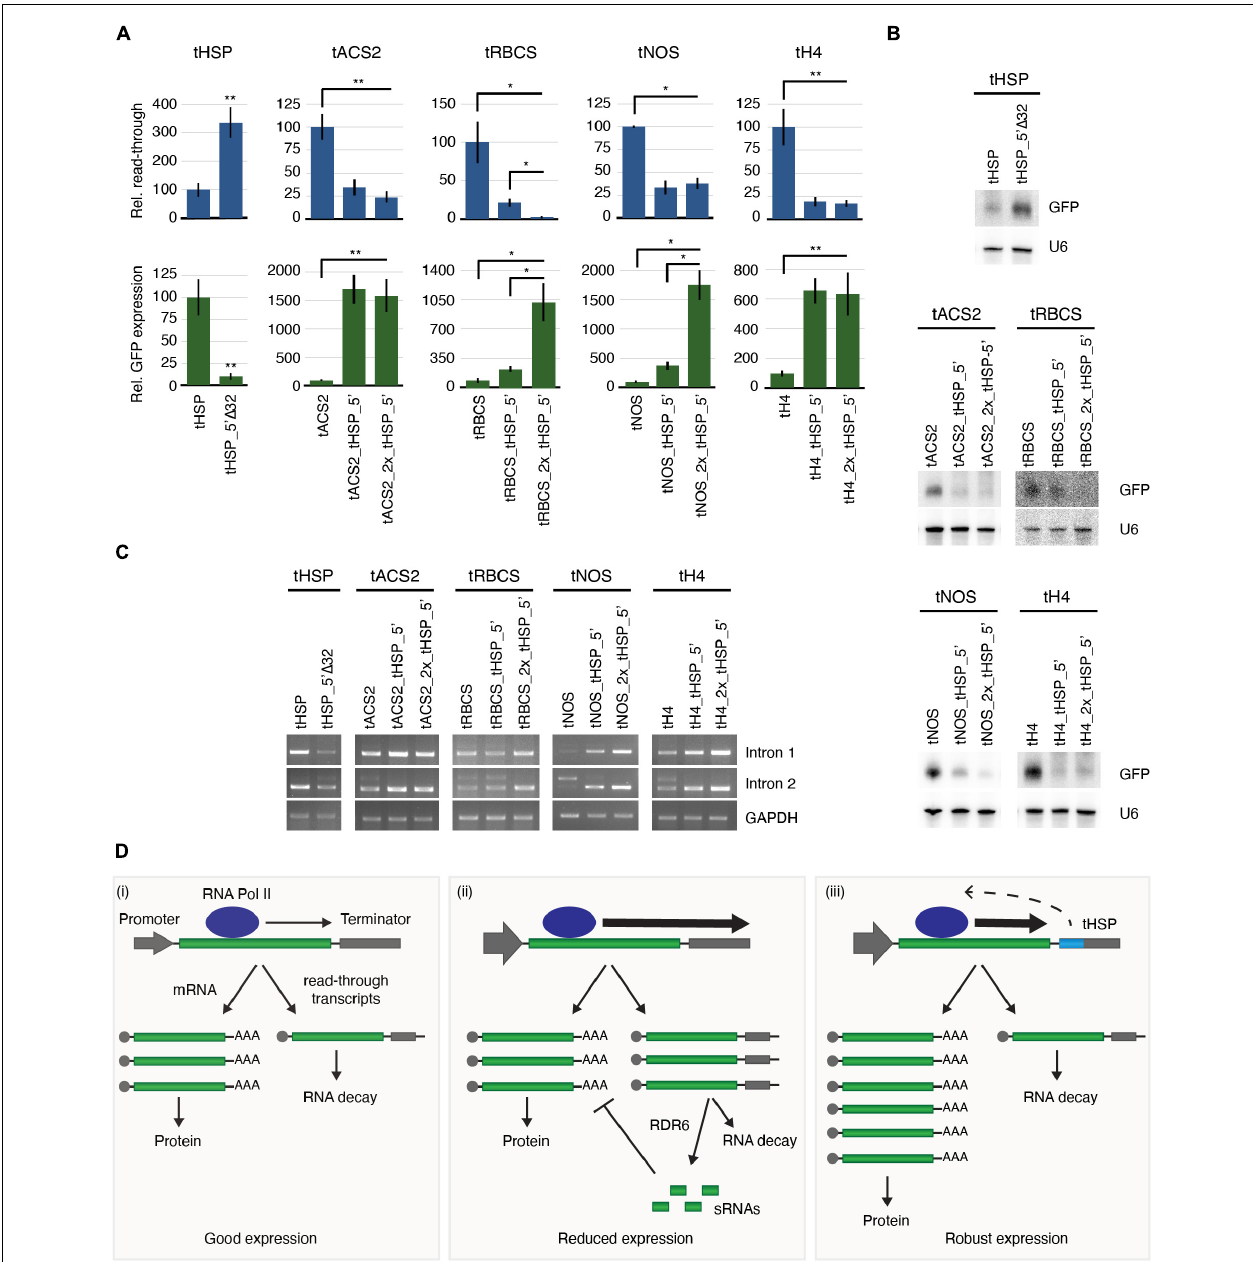
FIGURE 7 | The role of the tHSP 5 (cid:48) fragment on transcription termination, protection against sRNA production and splicing. (A) RT-qPCR analysis to detect read-through and GiFiP expression levels. All values are normalized to GAPDH ( GLYCERALDEHYDE 3-PHOSPHATE DEHYDROGENASE ) and are relative to the wild-type regulatory sequence. Read-through refers to the detection of a region of the T-DNA downstream of the terminator sequence. For the RT-qPCR analyses, three (tRBCS), four (tNOS), or six (tHSP, tACS2 and tH4) biological replicates were used. Each replicate is an infiltration spot originating from an independent plant. Standard error bars were calculated for the biological replicates. Statistically significant differences observed between the original and modified terminators, or between constructs carrying one versus two fragments of the tHSP (Mann-Whitney U test) are indicated by “*” ( p ≤ 0.05) or “**” ( p ≤ 0.01). (B) Northern blot to detect sRNAs derived from the GiFiP reporter. U6 was used as the RNA loading control. (C) RT-PCR to test splicing efficiency using primers flanking each of the introns in the GiFiP gene. GAPDH was used as the internal control. (D) Proposed model explaining how terminators carrying elements similar to the one found in the tHSP can contribute to a robust gene expression. (i) In a balanced situation, the RNA POLYMERASE II (RNA Pol II) produces only a small fraction of read-through transcripts, which are readily degraded by the RNA decay pathway. (ii) In cases where the terminator efficiency is not sufficient to cope with high rates of transcription (for instance, when strong promoters are used), the occurrence of read-through transcription increases and the resulting molecules overcome the RNA decay pathway, leading to the production of RDR6-dependent sRNAs and gene silencing. (iii) Terminators containing elements like the one found in the tHSP sequence, contribute to improving transcription termination, which results in low levels of aberrant transcripts being produced. As a consequence, sRNA generation is inhibited, allowing for a robust gene expression.